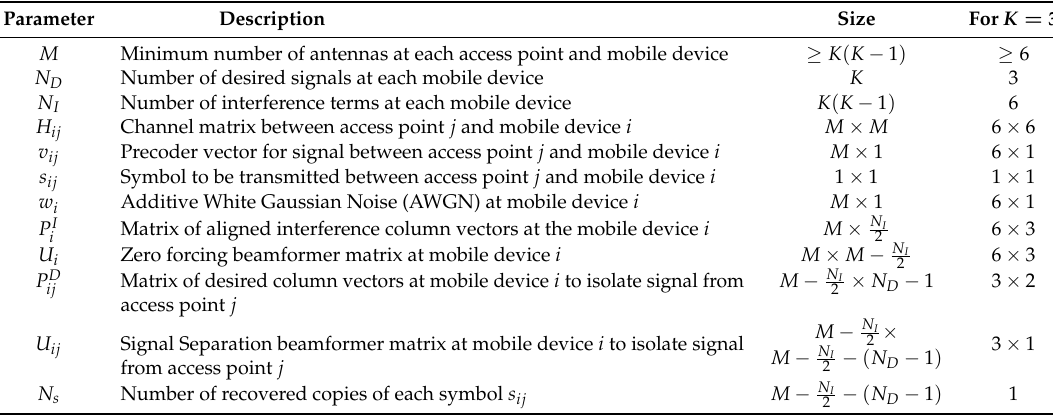
Table 1. System model parameters for key